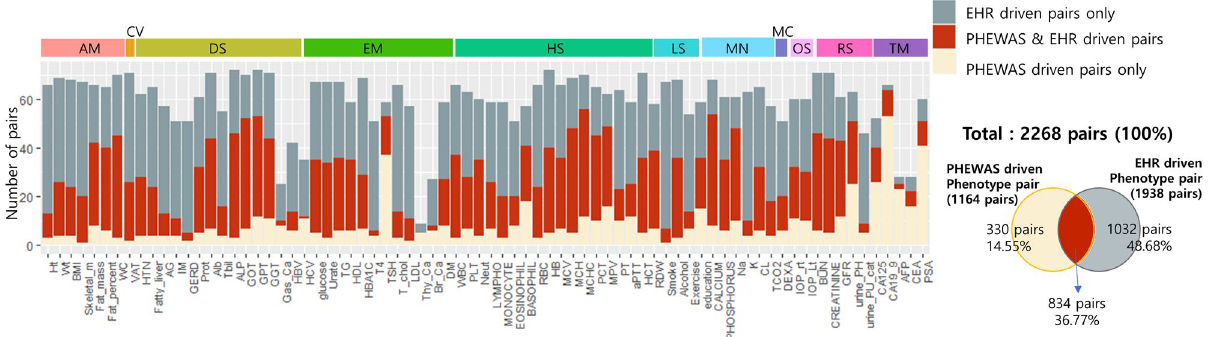
Figure 4. Comparison of phenotype-phenotype pairs between PheWAS driven and EHR-driven analysis. There were 76 phenotypes also recorded in the EHR-driven cohort (H-PEACE cohort). PheWAS-driven pairs (1164) were based on shared SNPs with association P < 1 × 10 –4 , and EHR-driven pairs (1938) on correlation analysis with multi-test corrected P < 0.05 (Table S26). Skeletal muscle mass (95%) and alkaline phosphatase (93.48%) had high ratios of overlap, while thyroid cancer (0%) and alpha fetoprotein (8%) had low ratios. In terms of biological categories, the average replication % was highest for anthropometric measurement (86.43%) Of the 1164 pairs from the PheWAS-driven approach, 834 (71.65%) also manifested significance in the EHR-driven